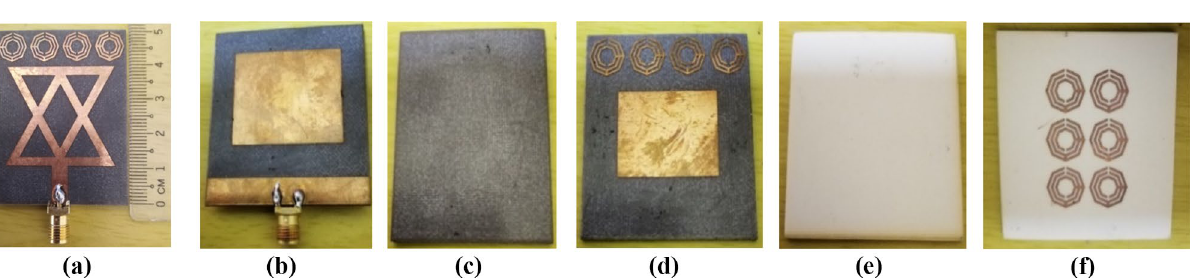
Figure 7. Fabricated three layers of the prototype: ( a ) Top view of TL; ( b ) Back view of TL; ( c ) Top view of ML; ( d ) Back view of ML; ( e ) Top view of BL; ( f ) Back view of